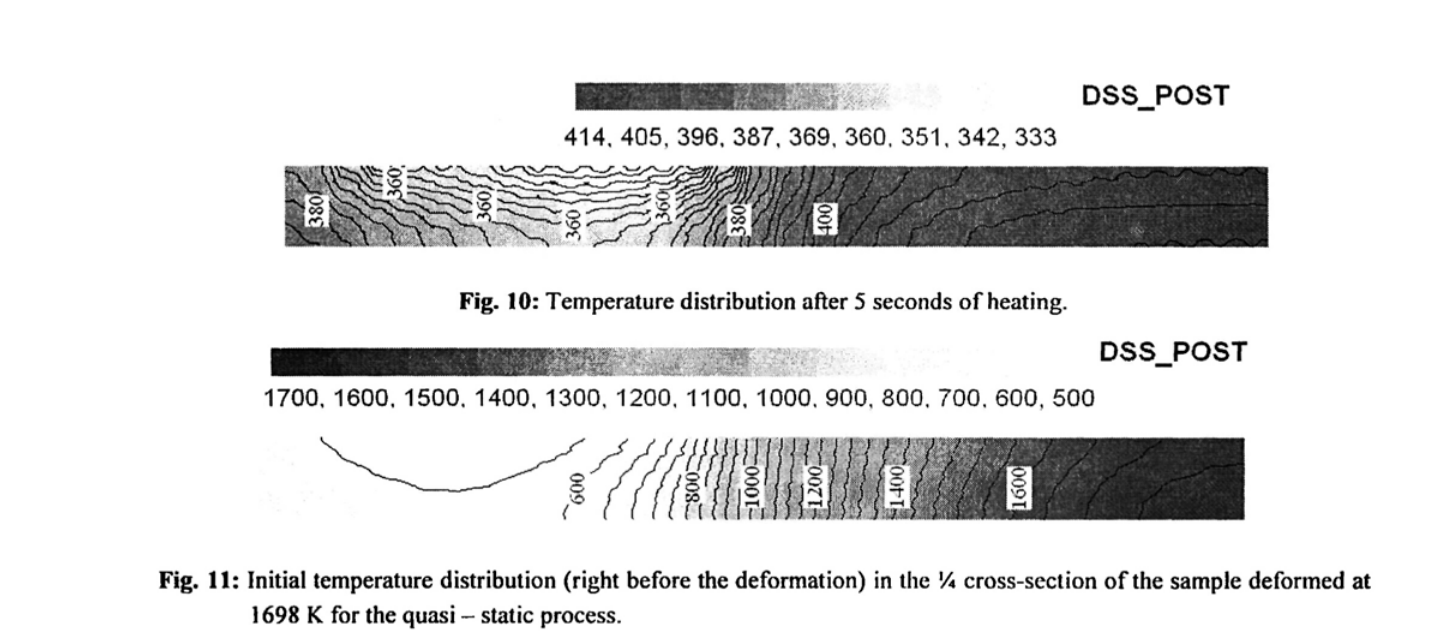
Fig. 11: Initial temperature distribution (right before the deformation) in the 'Λ cross-section of the sample deformed at 1698 K for the quasi - static process.